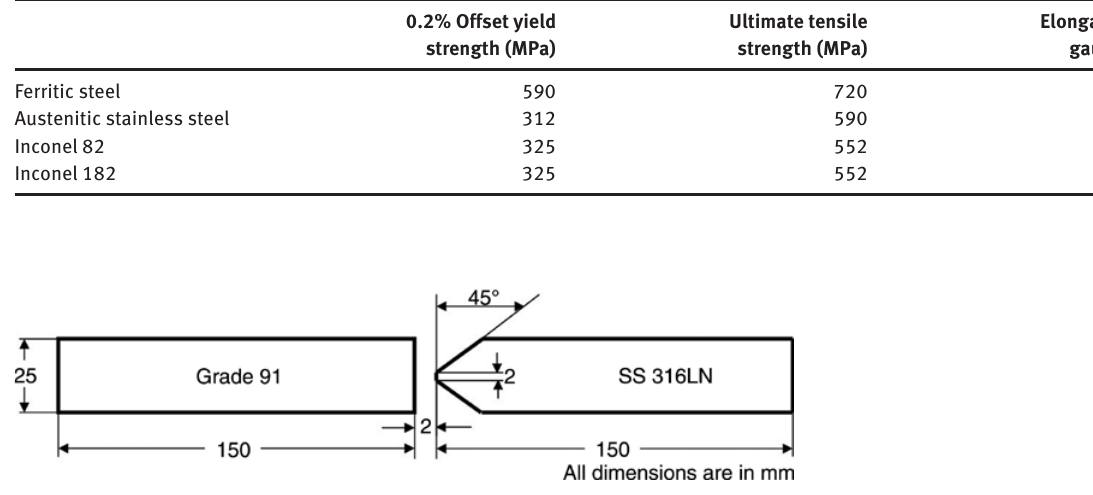
Table 2: Mechanical properties of base and filler metals.